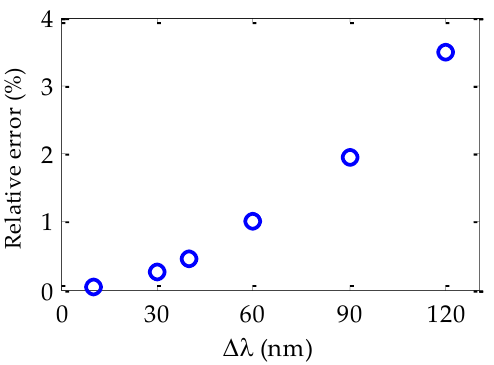
Figure 5. Relative error (%) obtained in the material dispersion coefficients as a function of the wavelength interval Δ λ for the 50 m Toray fiber.